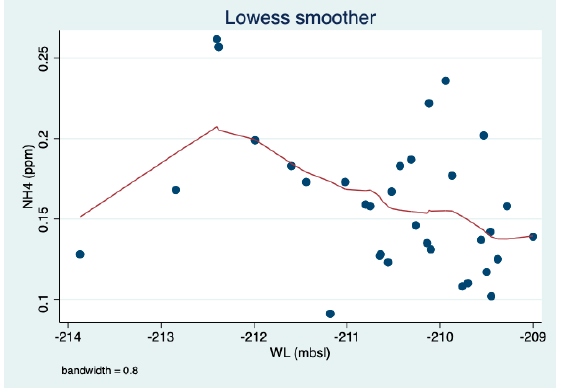
Figure 11. Trend of changes (Lowess smoother, 0.8 bandwidth) of annual lake averages of nitrate